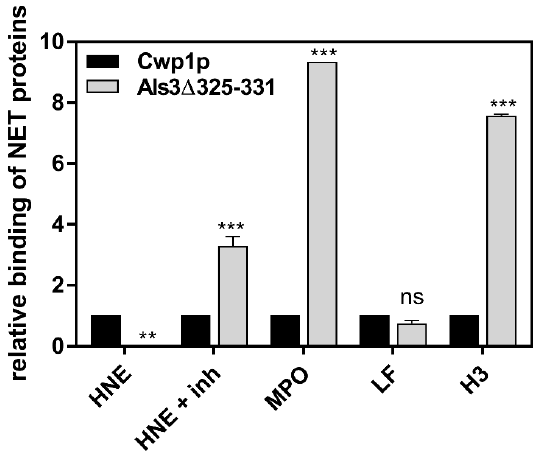
Figure 4. Binding of selected NET-composing proteins to S. cerevisiae cells bearing sur-